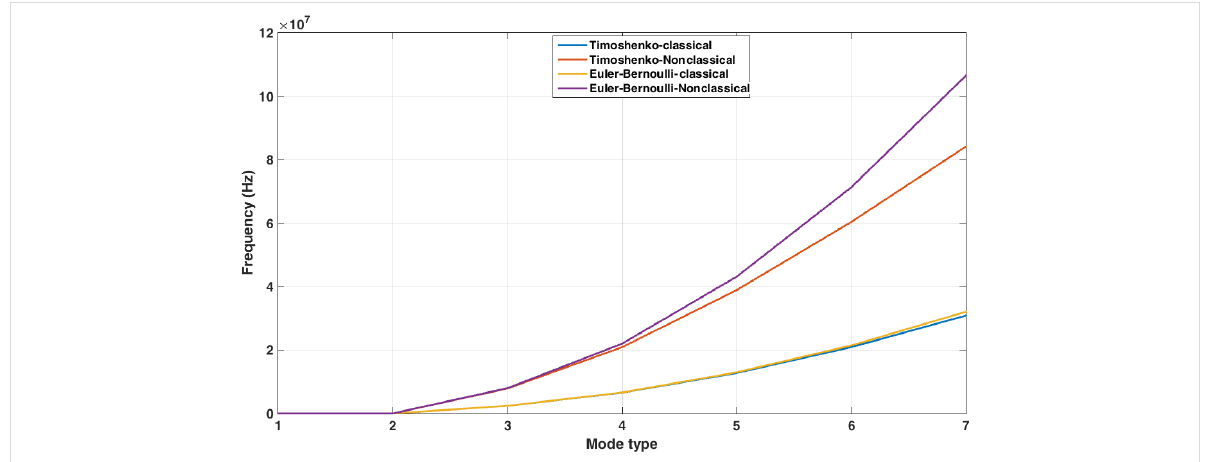
Figure 9: Natural frequencies of the classical and nonclassical models of a cylindrical gold nanoparticle with length of 25 μ m and aspect ratio of 30.